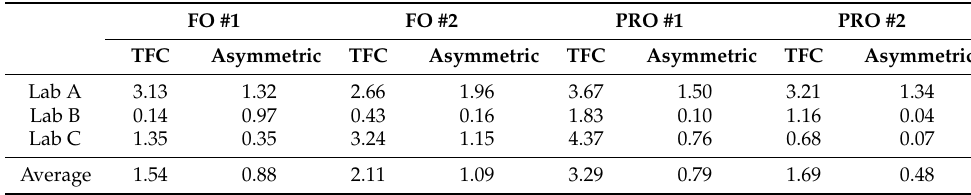
Table 2. Standard deviations of water flux (L/m 2 /hr) in the literature data.